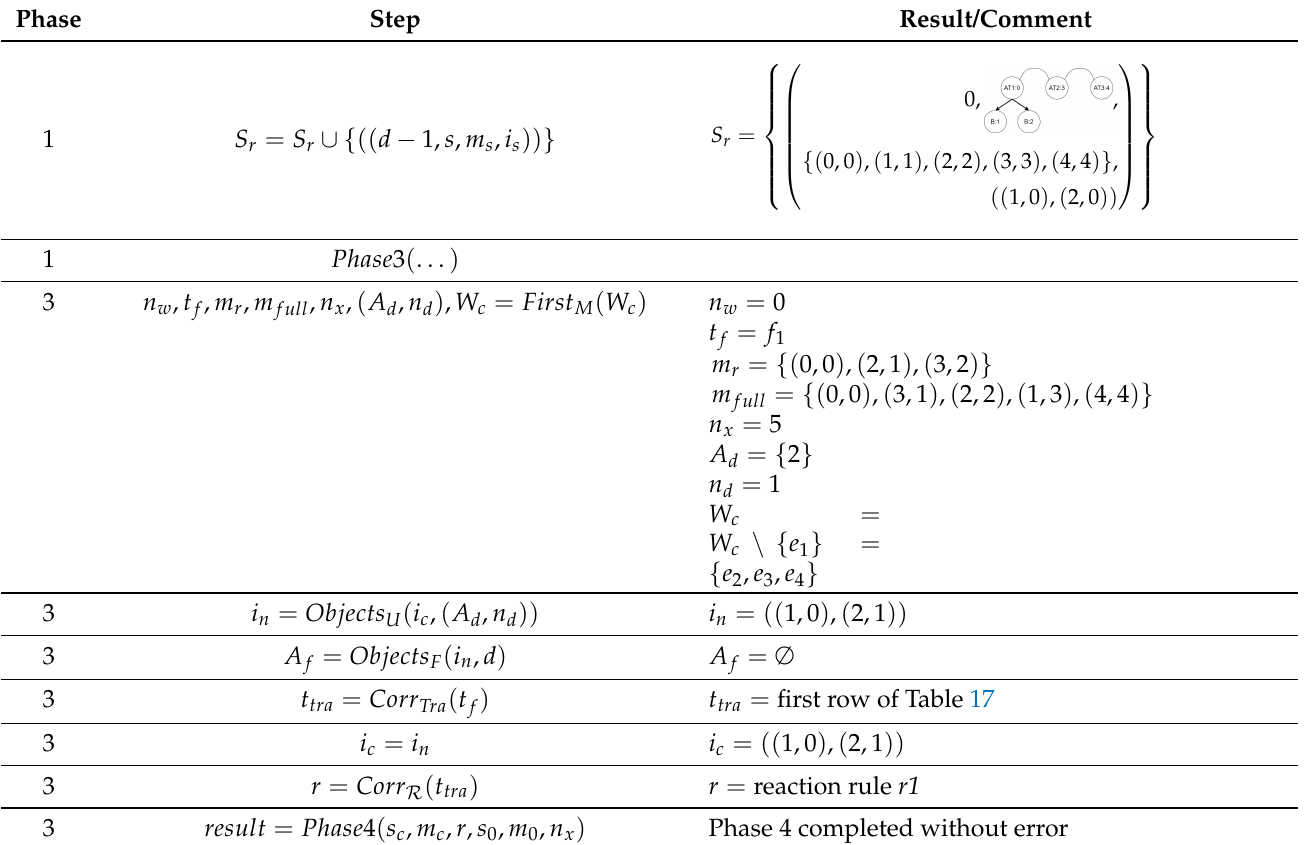
Table 18. Successive steps of the algorithm in the example of visualizing a scenario. Phase Step